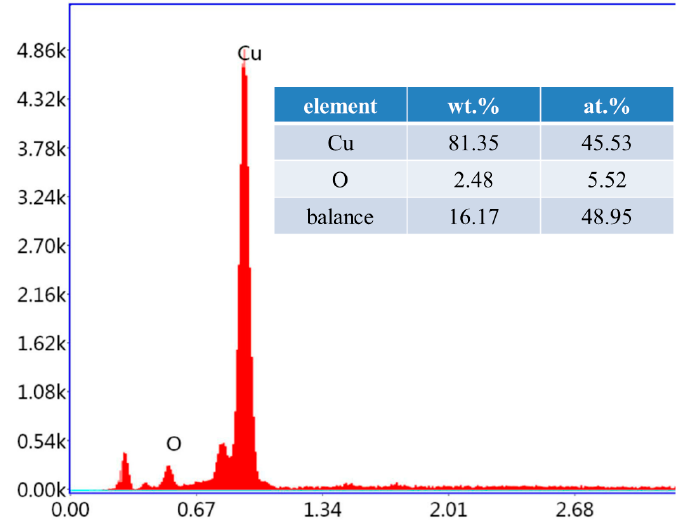
Figure 10. EDS analysis result of the worn pure Cu surface.